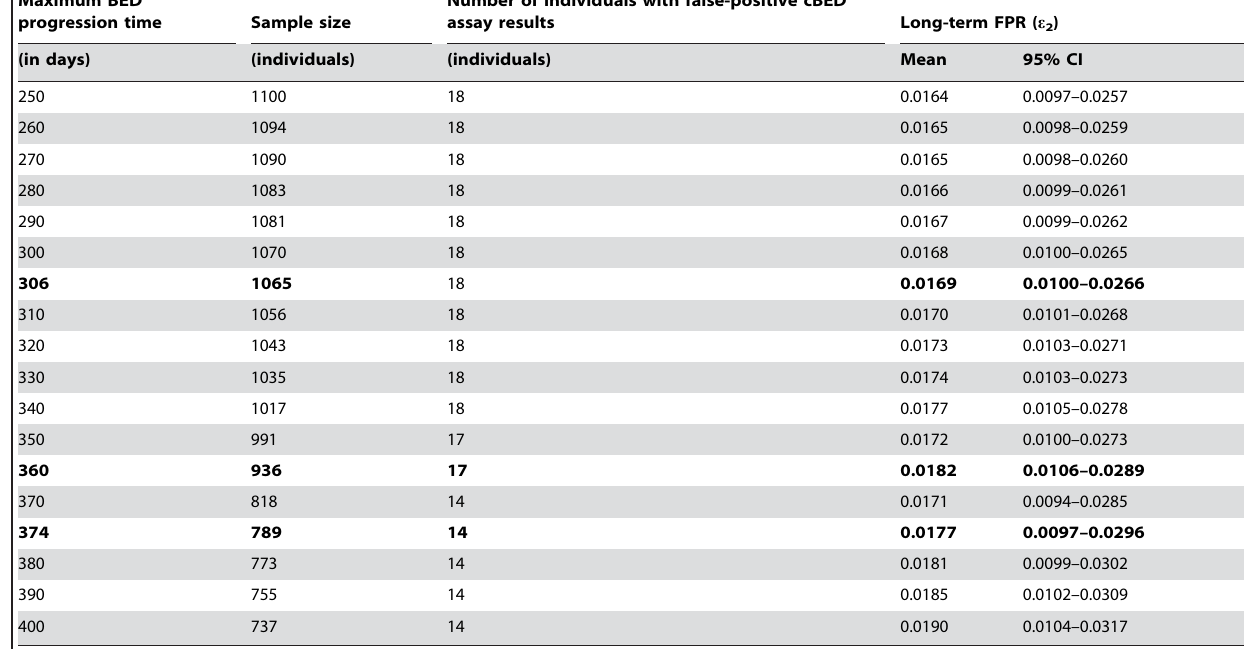
Number of individuals with false-positive cBED assay